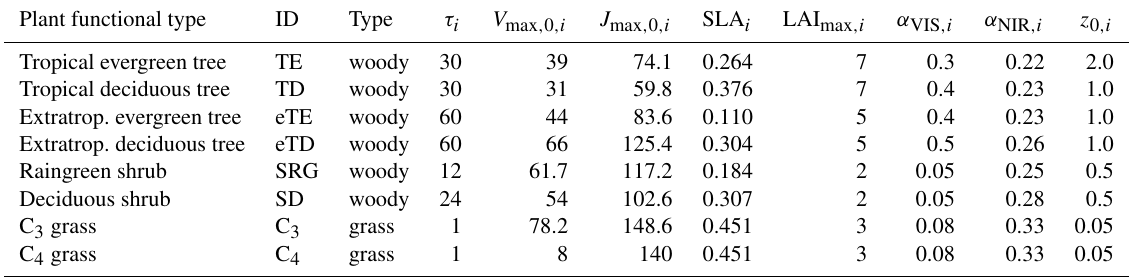
Table 1. Natural plant functional types in JSBACH, their woodiness type, associated time constants for establishment/mortality ( τ i , in years), maximum carboxylation capacities ( V max , 0 ,i ) and electron transport capacities ( J max , 0 ,i ) at 25 ◦ C (in µmolCO 2 m − 2 s − 1 ), specific leaf area (SLA i , in m 2 (leaf)mol − 1 (carbon)), maximum leaf area index (LAI max ,i , in m 2 m − 2 ), canopy albedo α i in VIS/NIR, and vegetation roughness length z 0 ,i (in m) (Reick et al.,